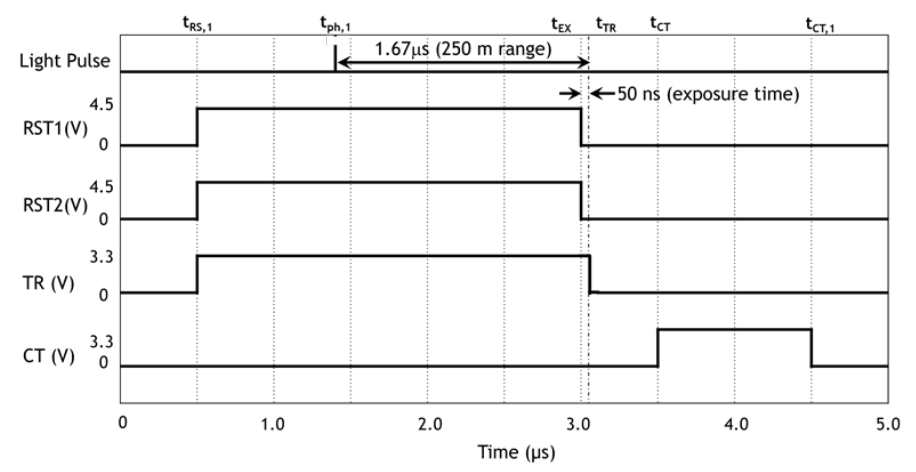
Figure 13. A schematic timing chart of important pulses used in the ranging experiment. The origin of time is only for convenience. The duration of laser pulse is 10 ns and the shape cannot be drawn with this scale.